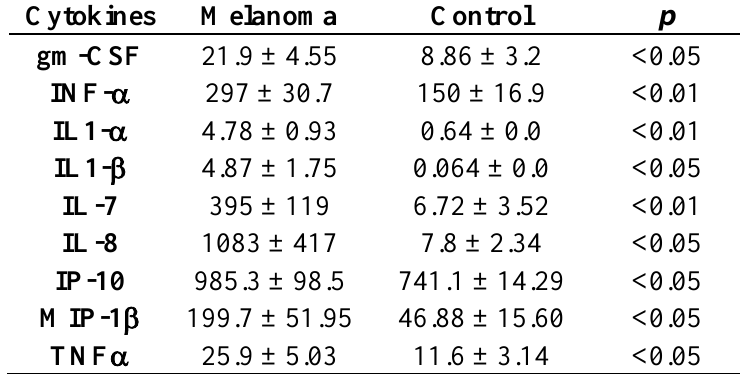
Table 3. Cytokine and chemokine expression in melanoma patients and healthy